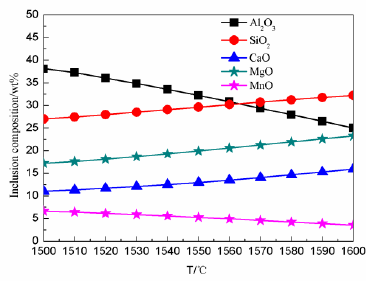
Figure 11. Effect of temperature on the inclusion composition.